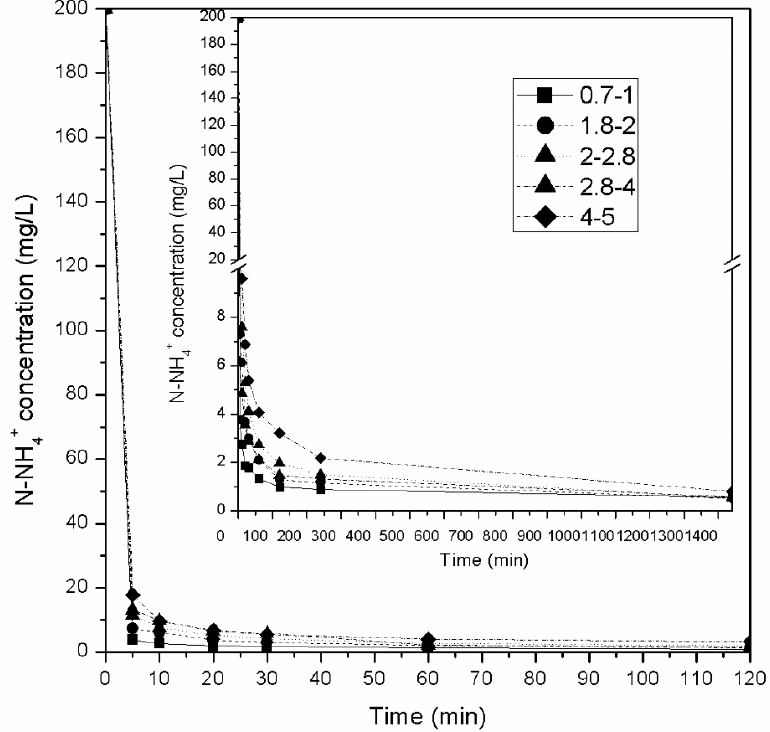
Figure 4. Effect of contact time on ammonium removal by natural zeolite of different particle sizes in column experiments and with initial NH 4+ -N concentration of 200 mg/L.